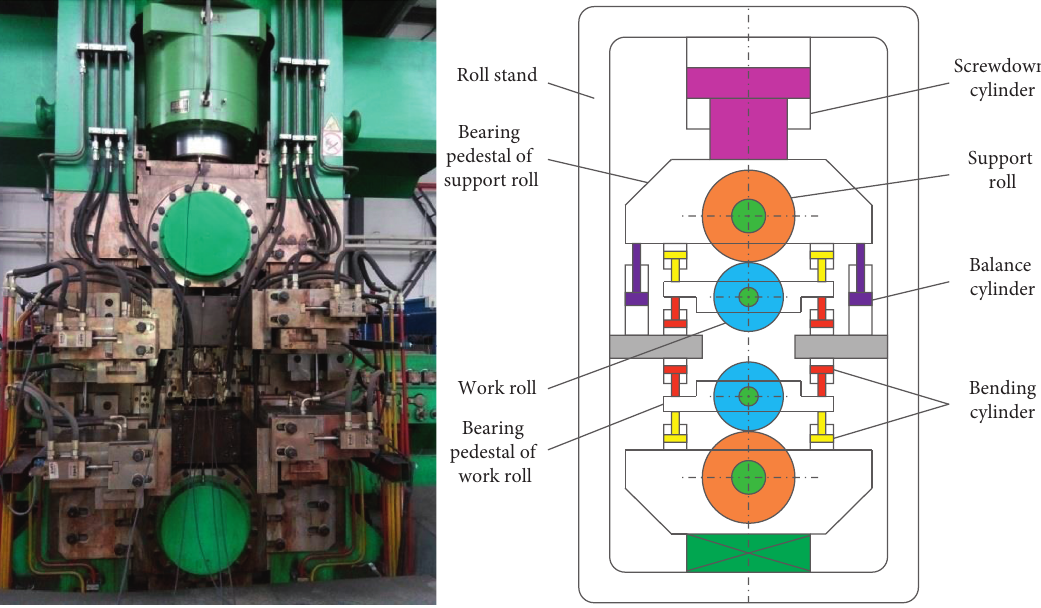
Figure 4: Schematic of load roll of four-high mill.